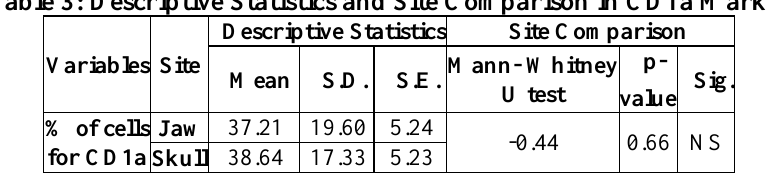
Table 4: Descriptive Statistics and Site Comparison in RANKL Marker